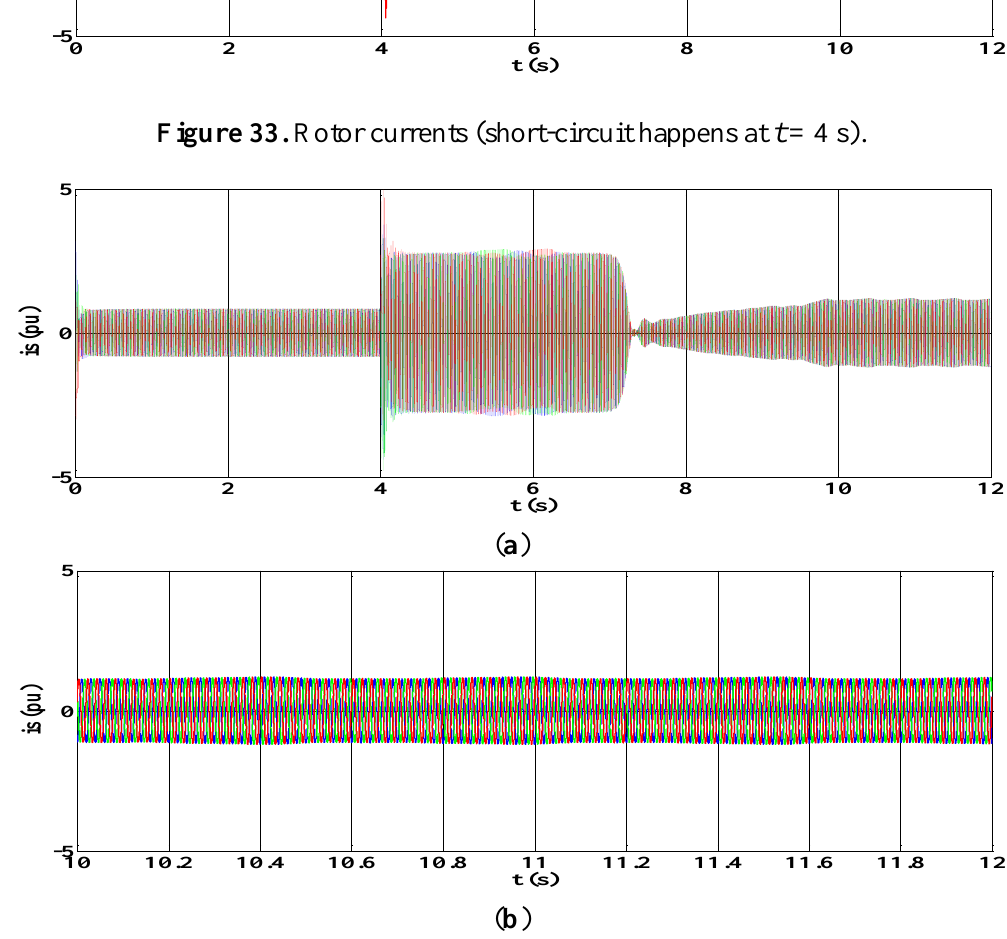
Figure 34. ( a ) Stator currents (short-circuit happens at t = 4 s), ( b ) zoom of